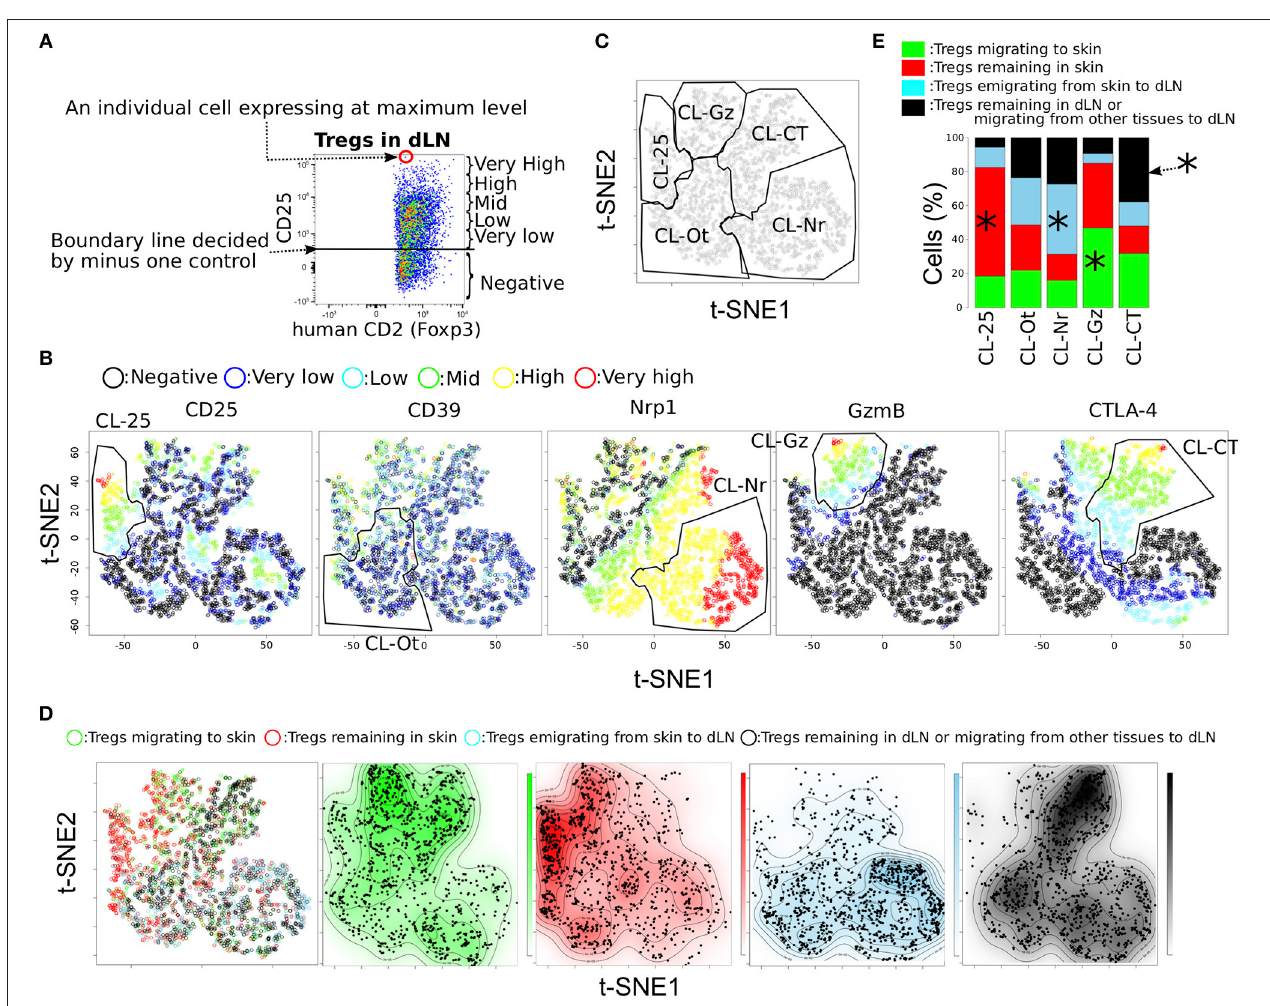
FIGURE 3 | Functional phenotypic diversity of skin and dLN Tregs with different migration activities. (A) Example defining the six expression levels of effecter molecules in Tregs. (B,C) tSNE projections for five proteins expressed in Tregs for pooled data from individual Tregs migrating to and remaining in skin and from Tregs emigrating from skin to dLN and Tregs remaining in dLN or migrating from other tissues to dLN ( n = 3). Six expression levels (defined as in a) are indicated by different colors. Clusters named CL-25, CL-Nr, CL-Gz, CL-Ot, and CL-CT were defined by manual gating (polygons). (D) Migration activities of individual cells are indicated in the tSNE plots by different colors. Distribution of the cells within each population is indicated by the four contour plots. (E) Proportions of Treg subpopulations with different migration activities within each cluster defined by manual gating. Asterisks indicate most significant proportions in each cluster.